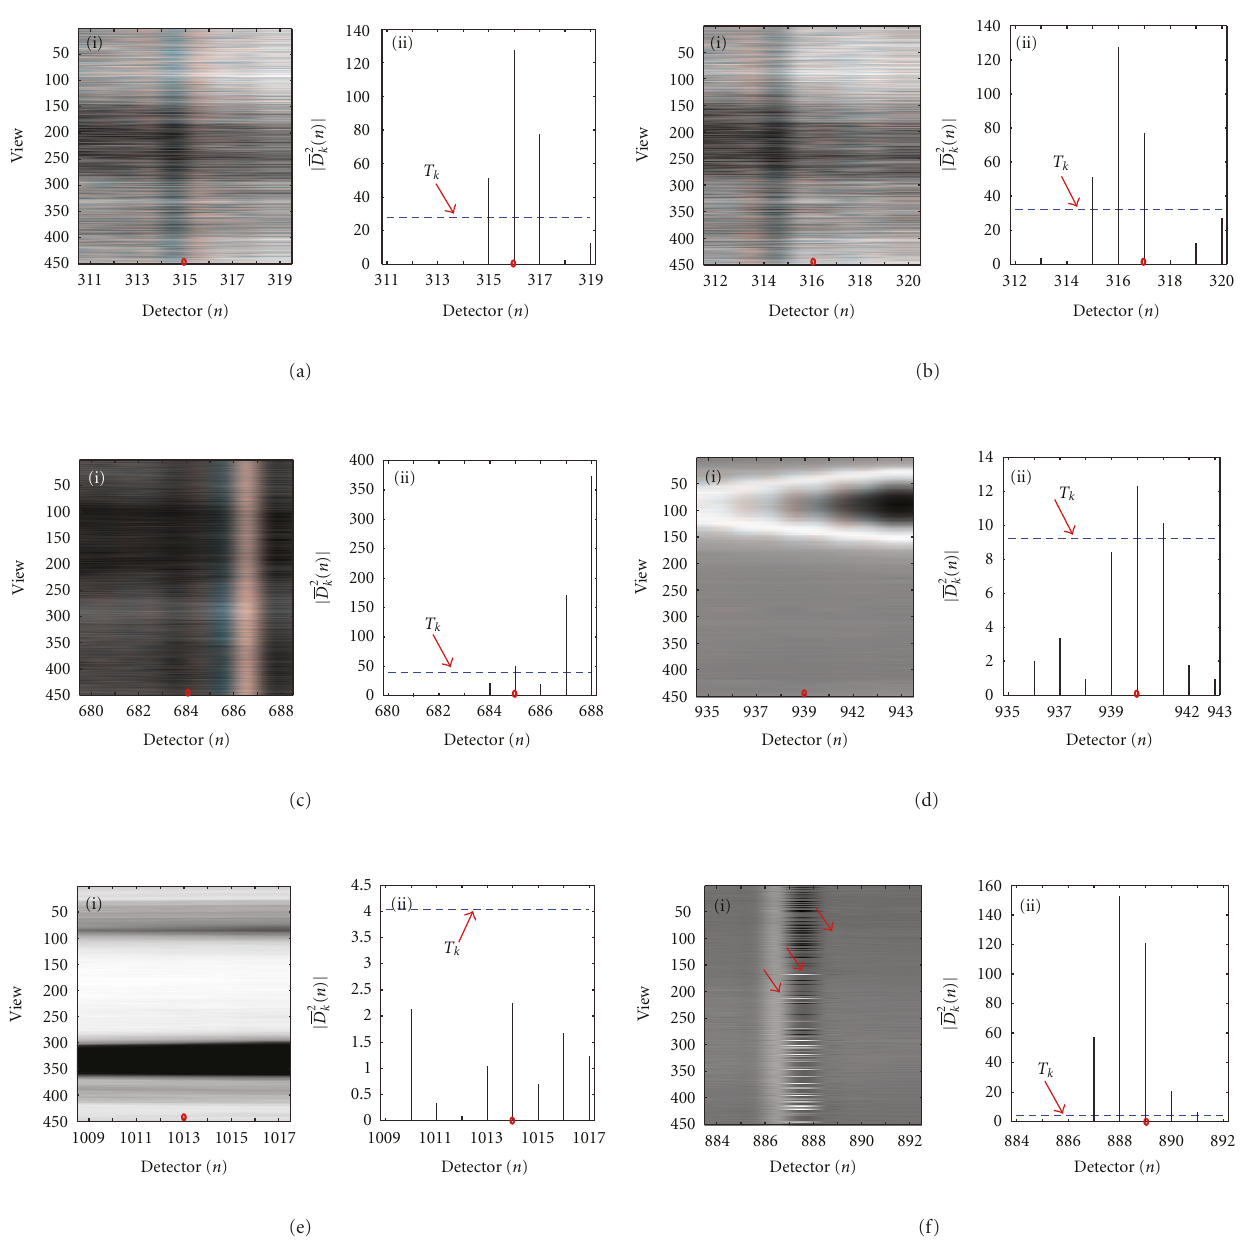
Figure 2: Examples of stripe detection using sinogram frames. a(i)–f(i) show some typical frames of a CT sinogram and (a)(ii)–(f)(ii) show n ) | and the corresponding threshold T T | D 2 k (dotted line). Dynamic nature of k is evident. (a) Moderate stripe at the center. (b) No stripe k ( at the center but one just before it. (c) Moderate stripe at the center but a very strong stripe in the neighborhood. (e) Very weak stripe at the center. (e) No stripe in the frame. | D 2 k ( n ) | may be misleading but the dynamic threshold confirms no stripe here. (f) Three consecutive stripes (887–889) where T k is unexpectedly low and | D 2 k ( n ) | are misleading. • shows the point of interest in each